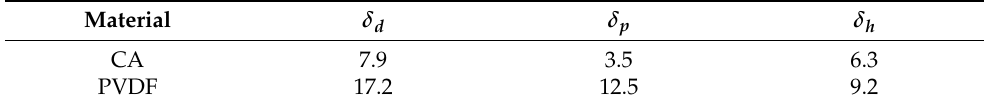
Table 2. Solubility parameters of CA and PVDF.